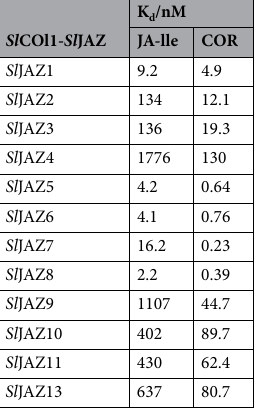
Table 1. K d values calculated from AlphaScreen analyses.